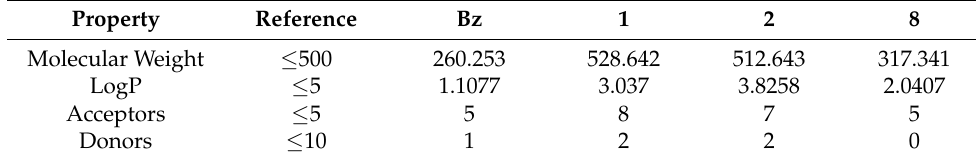
Table 5. Physicochemical parameters and Lipinski’s rule of five using pkCSM tool.